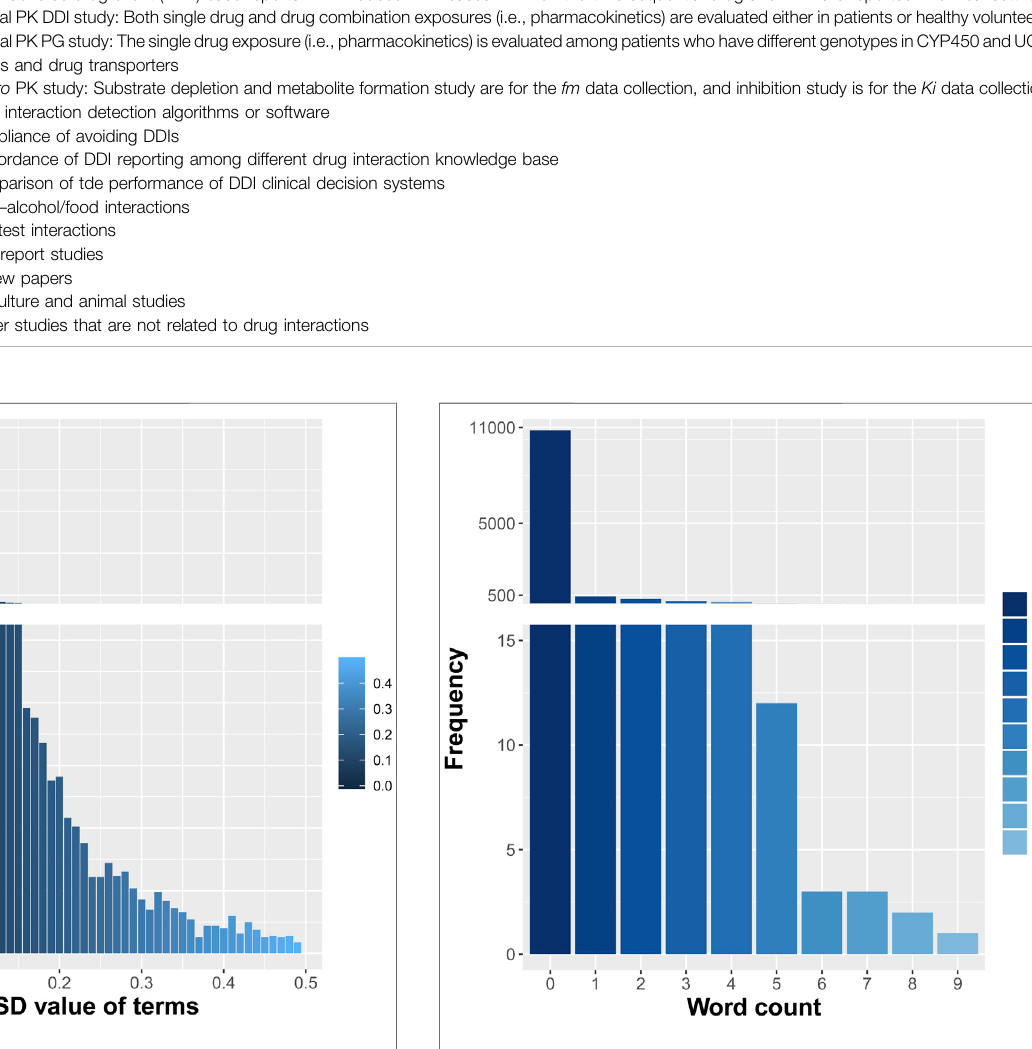
TABLE 1 | Inclusion and exclusion criteria for clinical drug safety drug – drug interaction (DDI) abstract selection. Inclusion Clinical trial DDI toxicity study: Phase I/II/III clinical trials in which drug combination and/or single drug toxicity data are evaluated and reported Pharmaco-epidemiological DDI study: Pharmaco-epidemiology studies in which toxicities from drug combinations are reported and compared to toxicities from a single drug DDI and adverse drug event (ADE) case reports: DDI-induced ADE cases in which the time sequential drug and ADE are reported in clinical settings Exclusion enzymes and drug transporters c) In vitro PK study: Substrate depletion and metabolite formation study are for the fm data collection, and inhibition study is for the Ki data collection